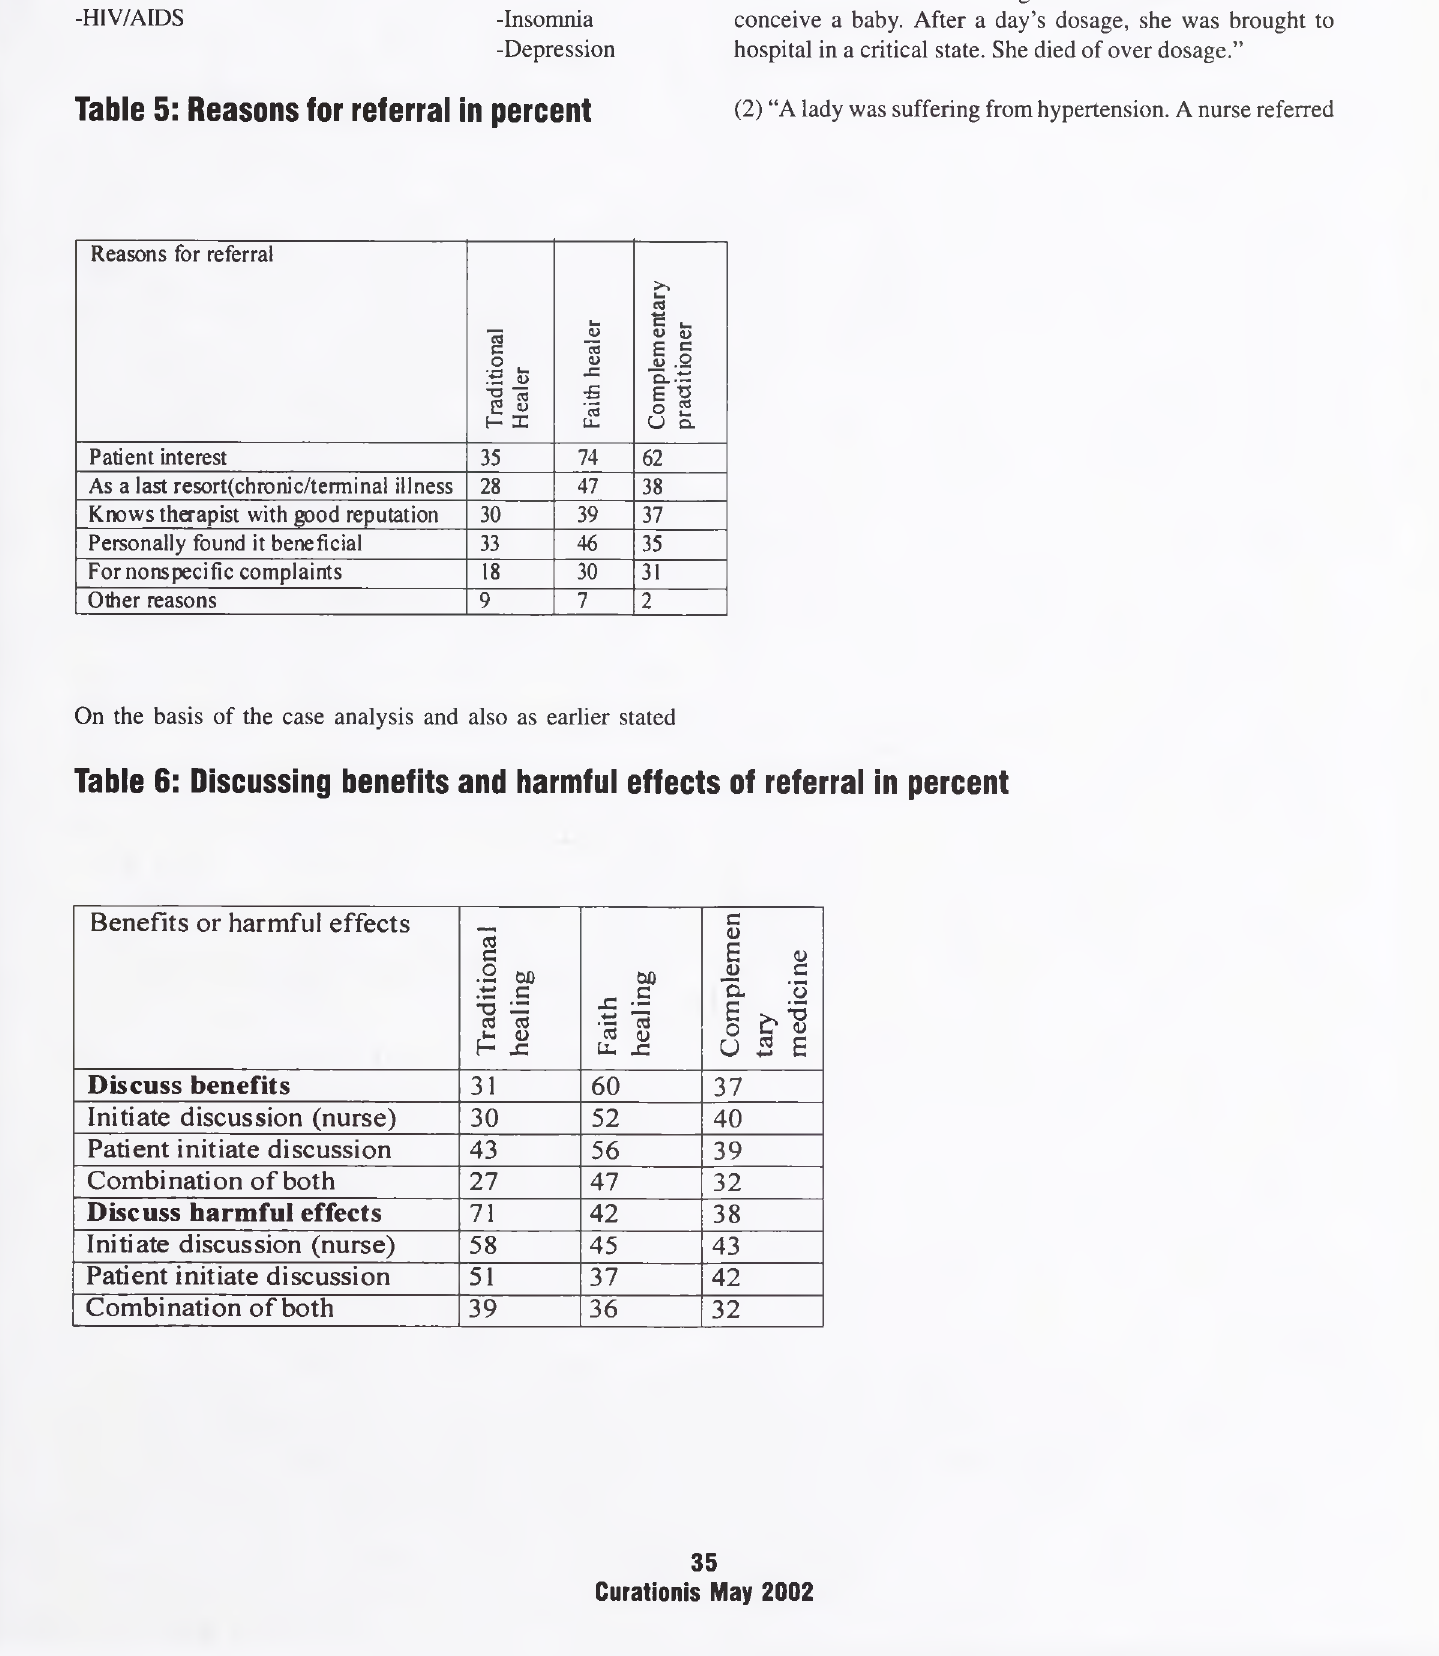
Table 5: Reasons for referral in percent